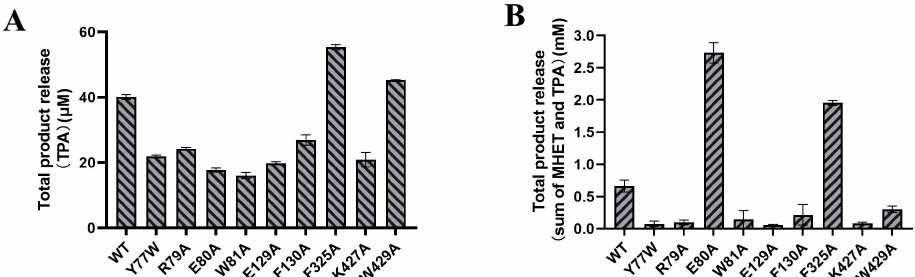
Figure 6. The hydrolysis activity of Tcca and its variants with PBAT and BHET. ( A ) The amounts of hydrolysis products released after 24 h degradation reaction with PBAT film by Tcca and its variants are shown. ( B ) The amounts of hydrolysis products released after 2 h degradation reaction with BHET by Tcca and its variants. BHET were converted to TPA and MHET by biocatalysis. The total product release was quantified as the sum of the UV − detectable small molecules by high − performance liquid chromatography system (HPLC). Each measurement was conducted in triplicate, from which the average values ± s.d. were calculated.